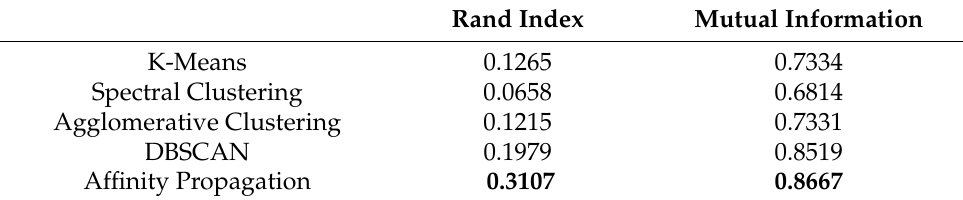
Table 4. The comparison results between the clustering methods.